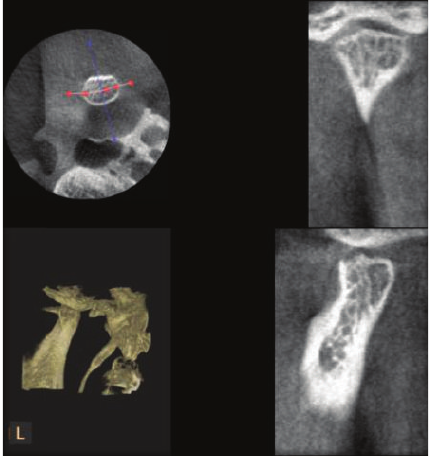
Figure 6: Osteophyte of condyle as seen in